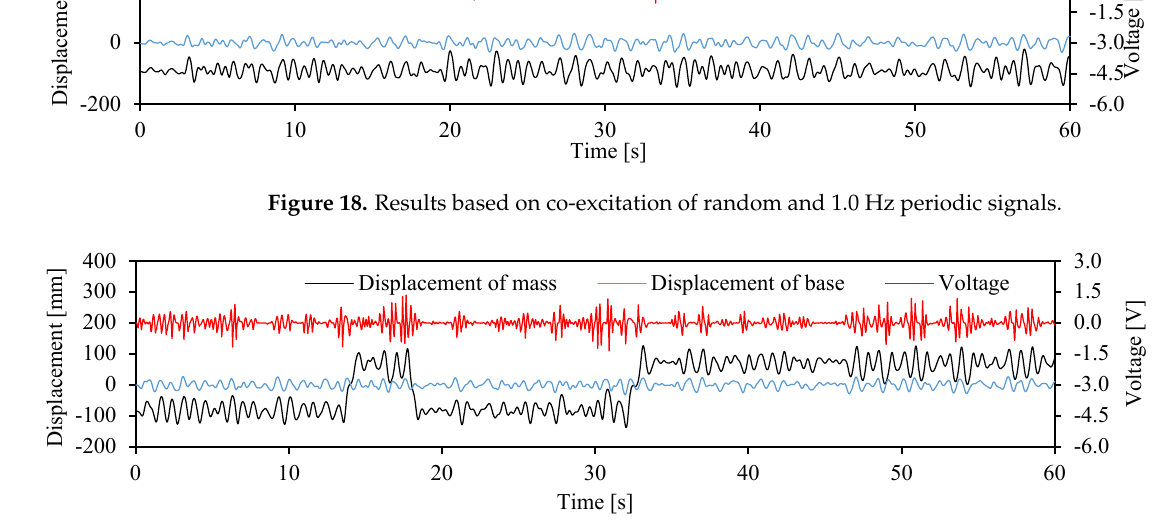
Figure 18. Results based on co-excitation of random and 1.0 Hz periodic signals.